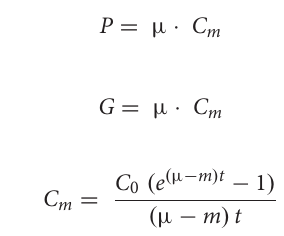
L − 1 d − 1 ) for every group was determined according Landry et